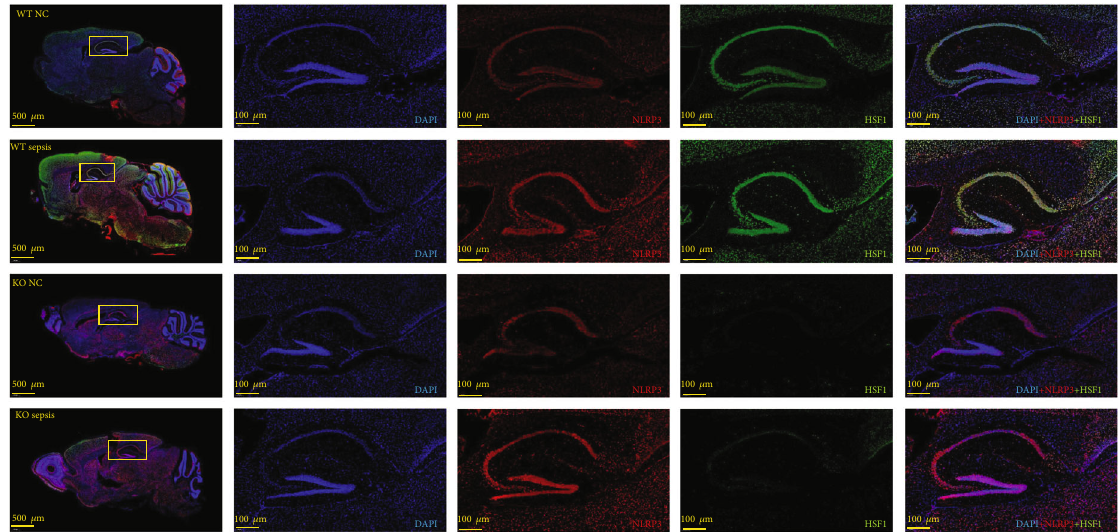
Figure 4: Immuno fl uorescence staining of NLRP3. Blue light: DAPI; FITC green light: HSF1; Cy3 red light: NLRP3. The photos were taken by the laser scanning microscope at 500 μ m (apply to the fi rst column from the left side) and 100 μ m (apply to the second to fi fth columns from the left